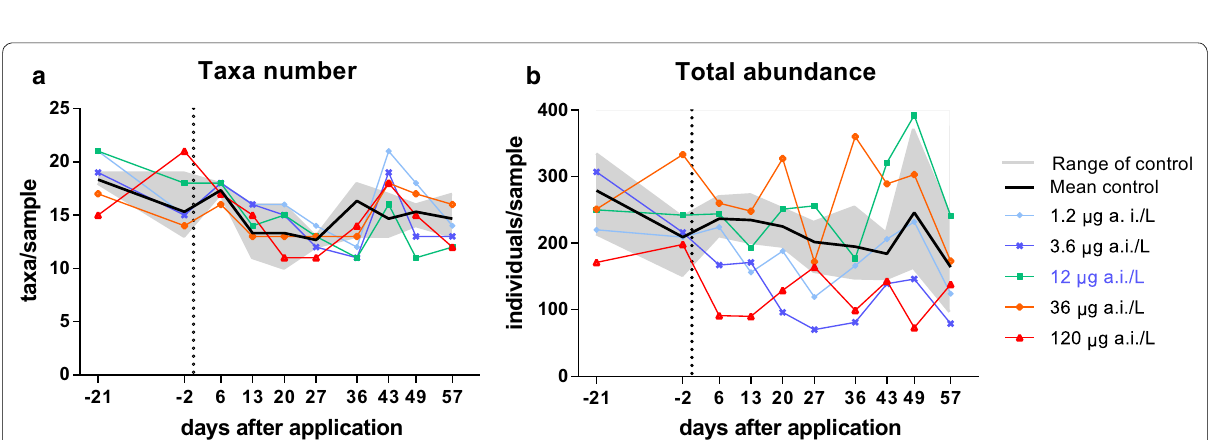
Fig. 4 Dynamics of a taxa richness and b total abundance of macroinvertebrates in the samples; dashed line: time point of